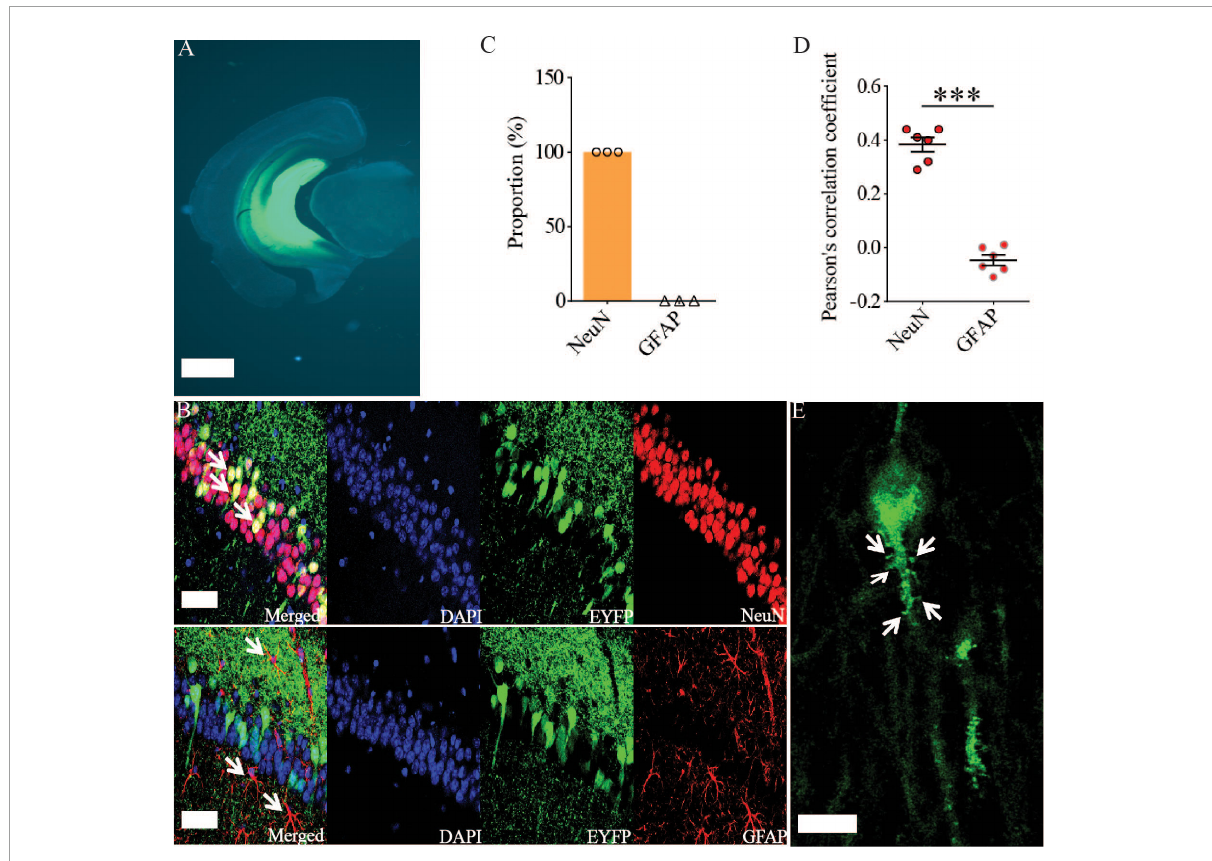
FIGURE2 Viral expression of Rac1-N17 in the ventral hippocampus. (A) Brain section image showing the expression of Rac1-N17-EYFP in ventral hippocampus. Scale bar: 1 mm. Confocal images (B) , summary graph of colocalized cells (C) , and Pearson’s correlation coefficient (D) showing the expression of Rac1-N17 (EYFP) colocalized with the neuronal marker NeuN, but not with the astrocytic marker GFAP. Arrows indicate neurons and astrocytes. Scale bar: 50 µ m. (E) Higher magnification confocal image showing expression of Rac1-N17 in the dendrite and spines (arrows). Scale bar: 10 µ m. *** P < 0 .